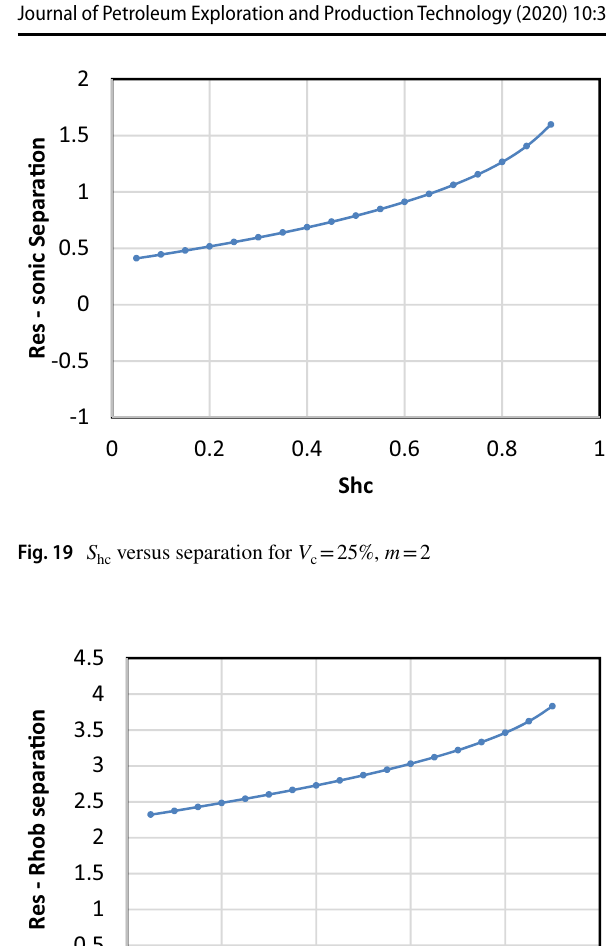
Fig. 20 S hc versus separation for